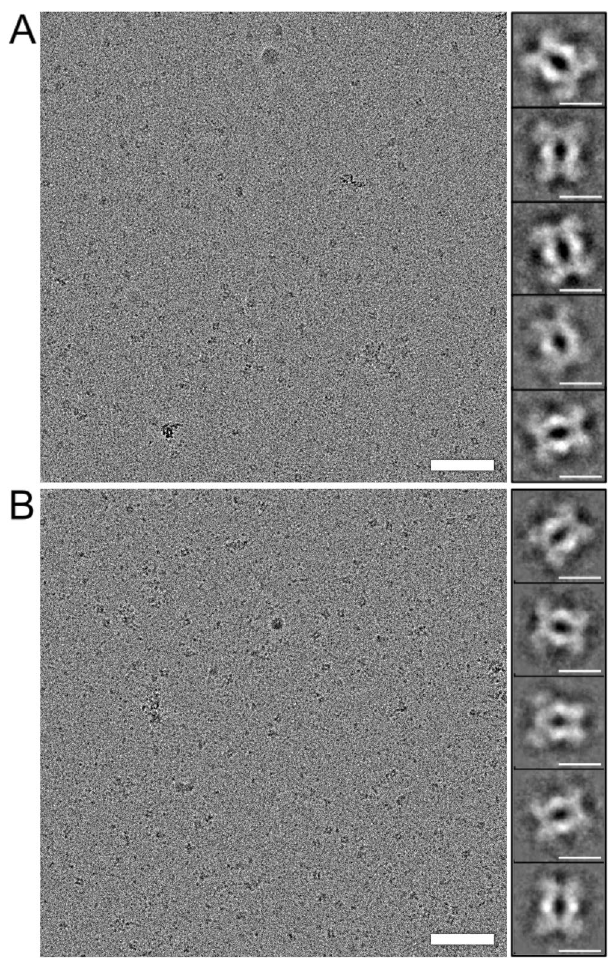
Figure 5. Cryo-EM and single particle processing of 3xflag-LRRK2 and 3xflag-LRRK1. ( A ) LRRK2 complexes eluted in Hepes buffer at pH 8.2, imaged by cryo-EM. Right: Selected EMAN2 class averages showing characteristic side-views of the complex. Particles in this view are ~17 nm long and ~12 nm wide. Their two- fold symmetry indicates that the complex is a dimer. ( B ) LRRK1 complexes eluted in Tris buffer at pH 7.4, imaged by cryo-EM. Right: Selected EMAN2 class averages showing characteristic side-views of the LRRK1 complex. These are very similar to corresponding side-views of LRRK2 but slightly smaller, being ~16 nm long and ~10 nm wide. The dimeric arrangement is apparent. Scale bars: 100 nm for the micrographs, 10 nm for the